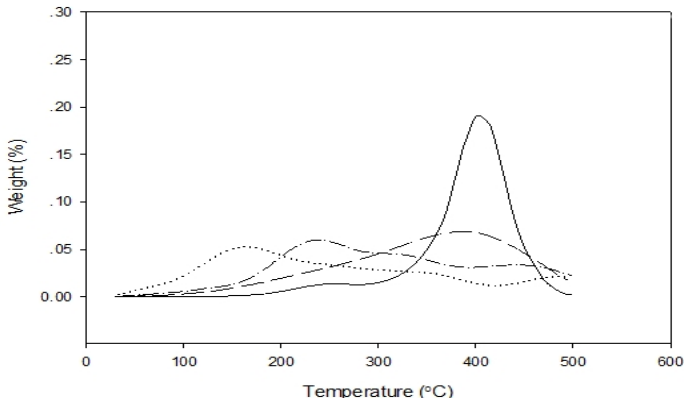
Figure 4. Percent weight against temperature on the effect of reaction temperature. ( 325 °C, 350 °C , 375 °C, 400 °C).